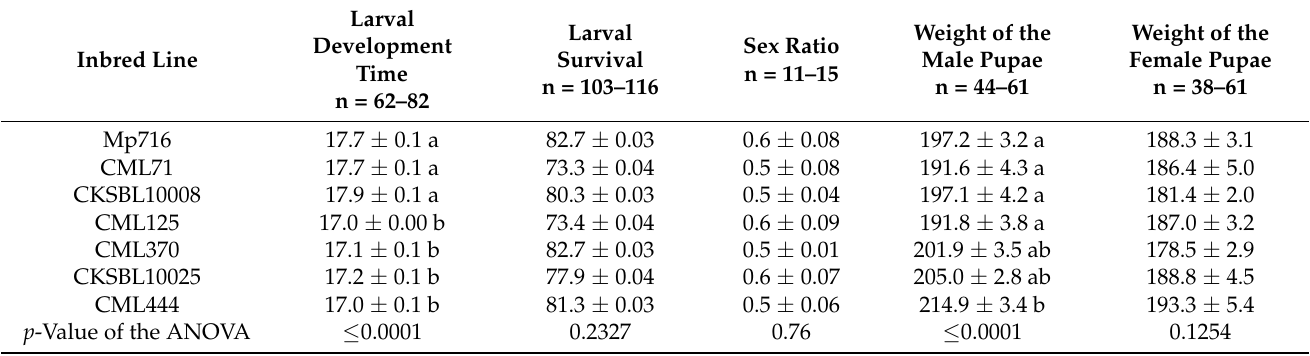
Table 1. Larval development time (in days), larval survival (%), sex ratio and weight of male and female pupae (mg) from Spodoptera frugiperda larvae fed on leaf portions from different maize inbred lines under laboratory conditions. For each parameter, mean 1 ± SE are presented.